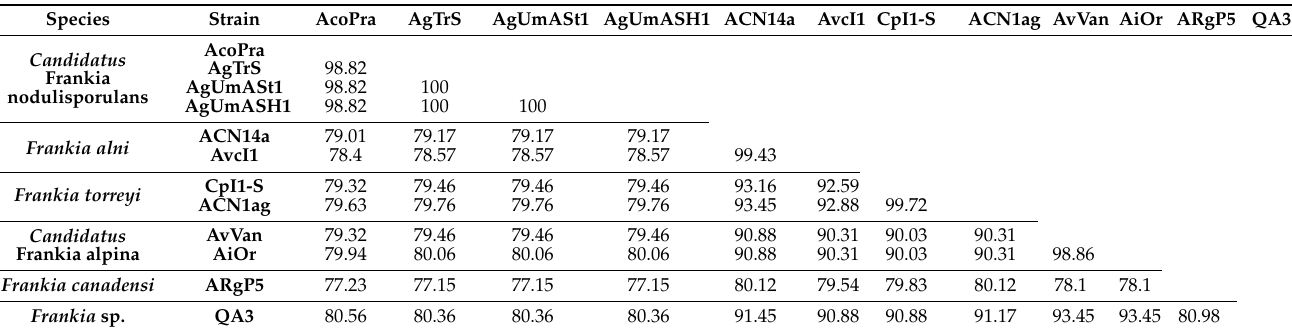
Table 4. Percent Identity Matrix calculated from AgD protein sequences of the 12 Frankia strains from Cluster Ia using the Clustal Omega alignment